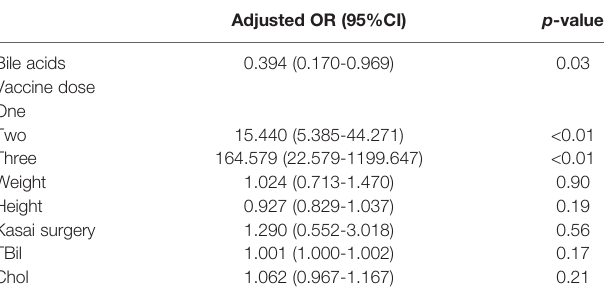
TABLE 5 | Multivariate logistic regression analysis of factors affecting the immune response to the HBV vaccine between the high and low TBA